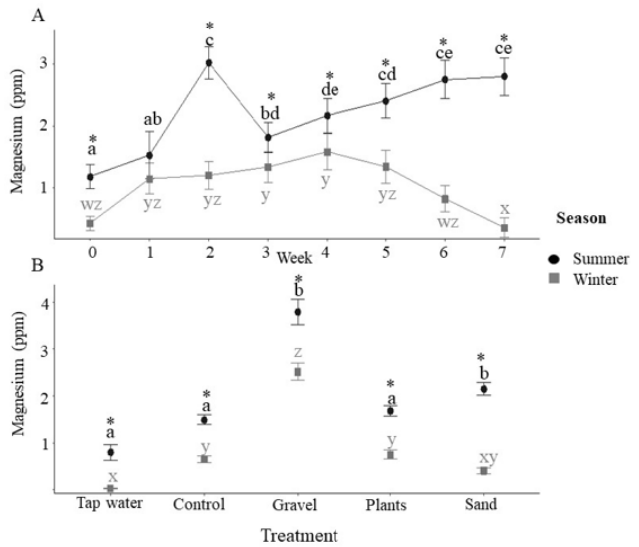
Figure 6. Tank concentrations of magnesium. ( A ) Magnesium concentrations (ppm) during summer and winter for each week of the 7-week experimental period ( n = 20 tanks at each time point combined across treatments). Asterisks indicate significance between seasons within a time point and different letters indicate significance between weeks within the same season (post-hoc Tukey p < 0.05). ( B ) Magnesium concentration (ppm) by enrichment method with incoming tap water values also presented (tap water: n = 7; for control, gravel, plants, sand, n = 35 i.e., 5 tanks × 7 weeks with data combined across time). Asterisks indicate significance between seasons within a treatment and different letters indicate significance between treatments within the same season (post-hoc Tukey p < 0.05). All data are means ± SEM.